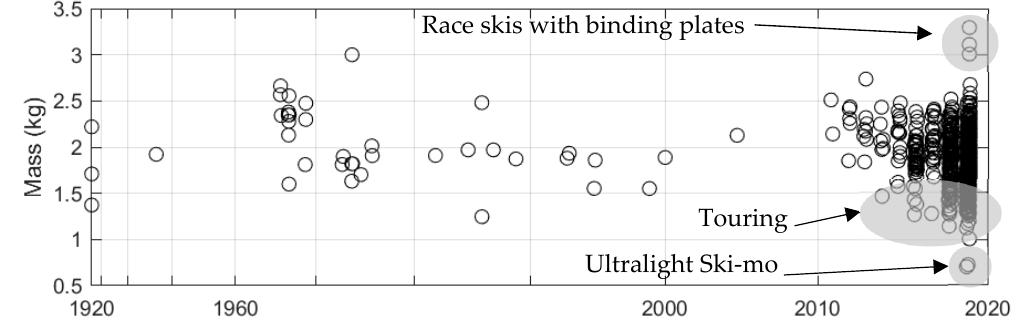
Figure 8. Ski mass vs. model